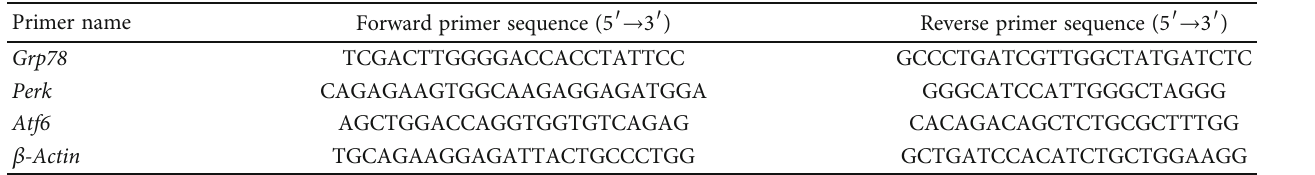
Table 1: Primers used in this